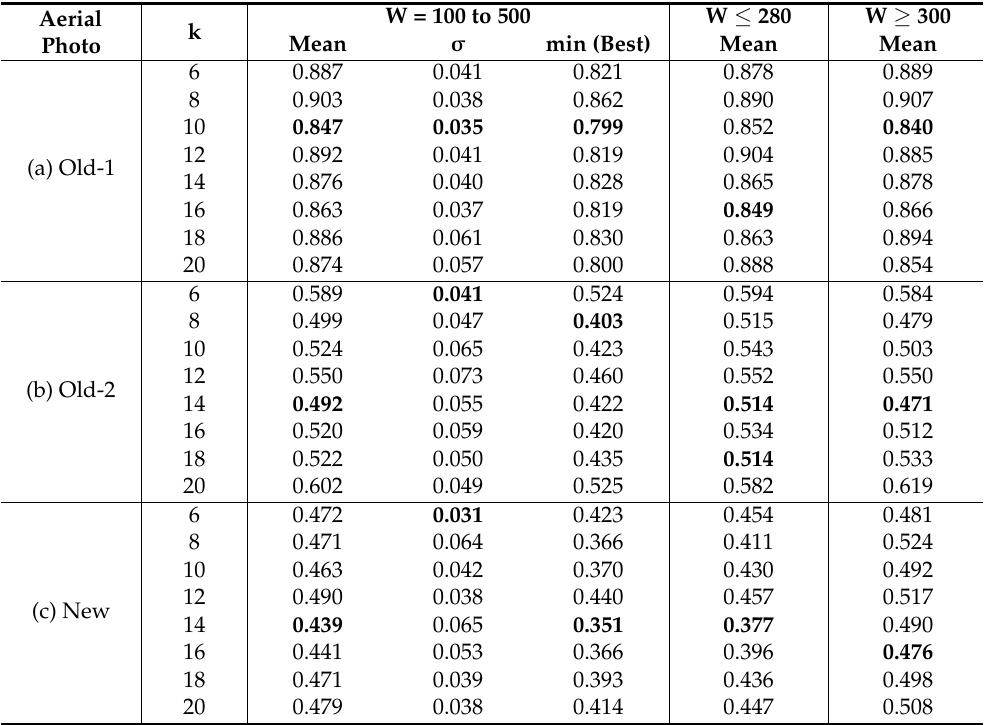
Table 4. Mean, standard deviation and minimum values of RMSD of inter-GCP residuals for different loss function weights (k) for sub-image size (W) from 100 to 500 at 20-pixel steps using (a) old-period aerial photo 1, (b) old-period aerial photo 2 and (c) new-period aerial photo as target images (unit: pixel). RMSD means for W ≤ 280 and W ≥ 300 are also shown. Minimum (best) value for each image in each set of W is shown in